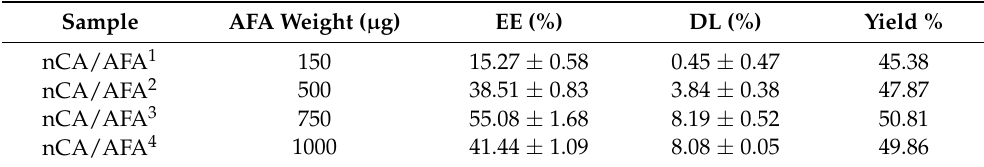
Table 3. Encapsulation efficiency (%), drug loading (%), and yield of nanocomposites according to different afatinib weights used.